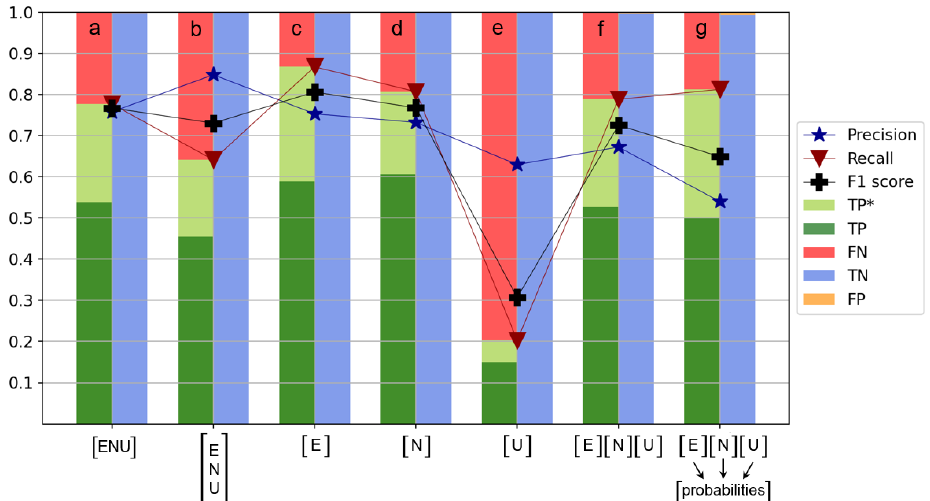
Figure 14. Classification result for testing stations for different model constellations. Every pair of brackets visualizes a machine learning model. The content between the brackets visually represents the feature matrix design. Thereby, E stands for the east, N for north and U for the up component. ( a ): chunks from the individual components are combined to one sample. ( b ): every chunk represents its own sample. ( c – e ): model trained only on one component. ( f ): The results of ( c – e ) are combined for making a final prediction. ( g ): The class probabilities from case ( c – e ) are used as features for a second layer of machine learning model. A more detailed description of the figure content and acronyms are presented in the captions of Figures 4 and